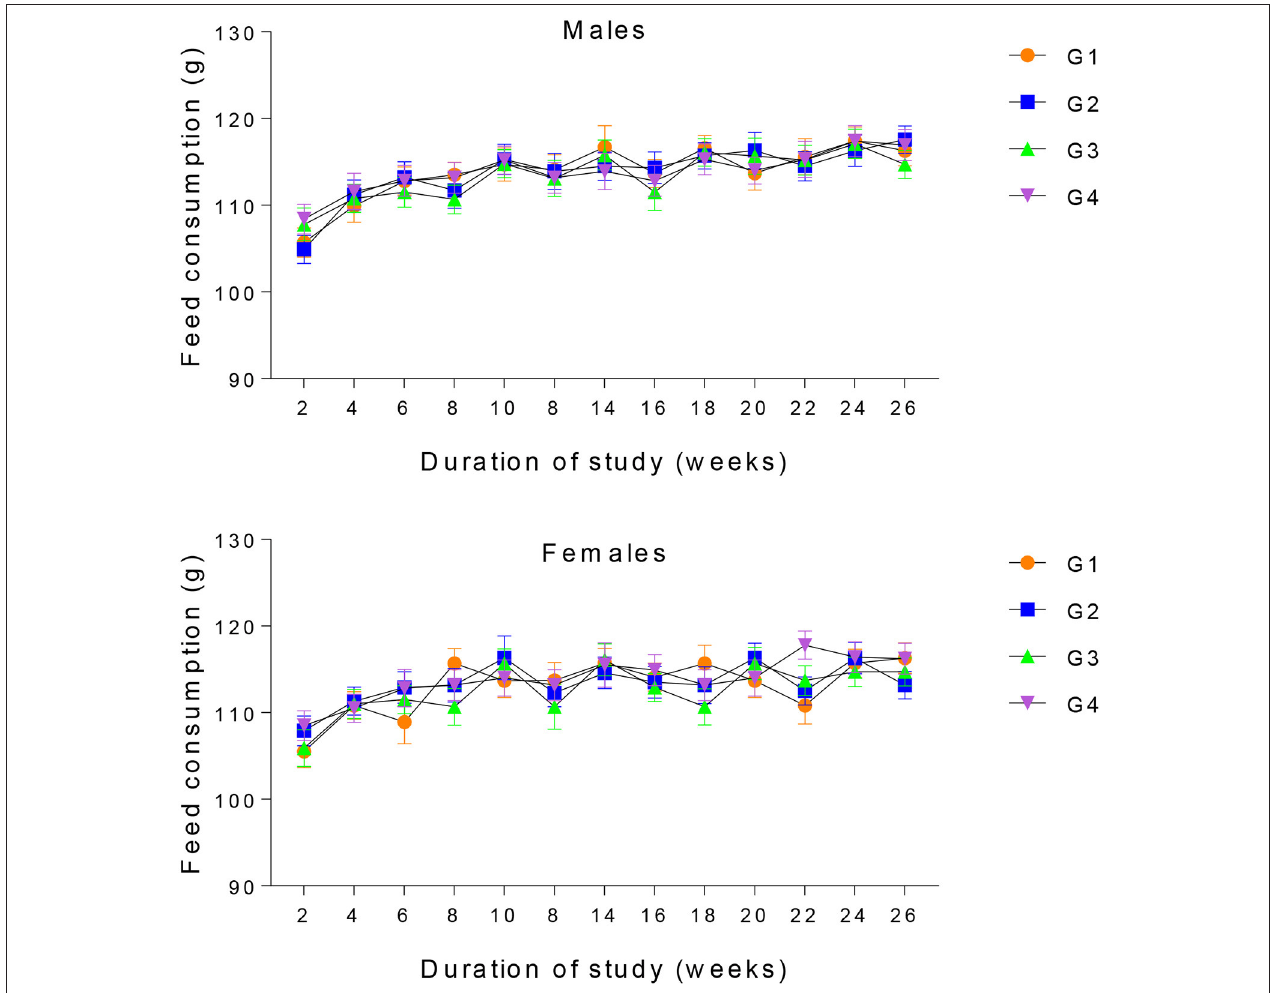
FIGURE 1 | Mean feed consumption of male and female rabbits. G1 represent the Control group. G2, G3, and G4 represent 20, 30, and 40% GM cotton